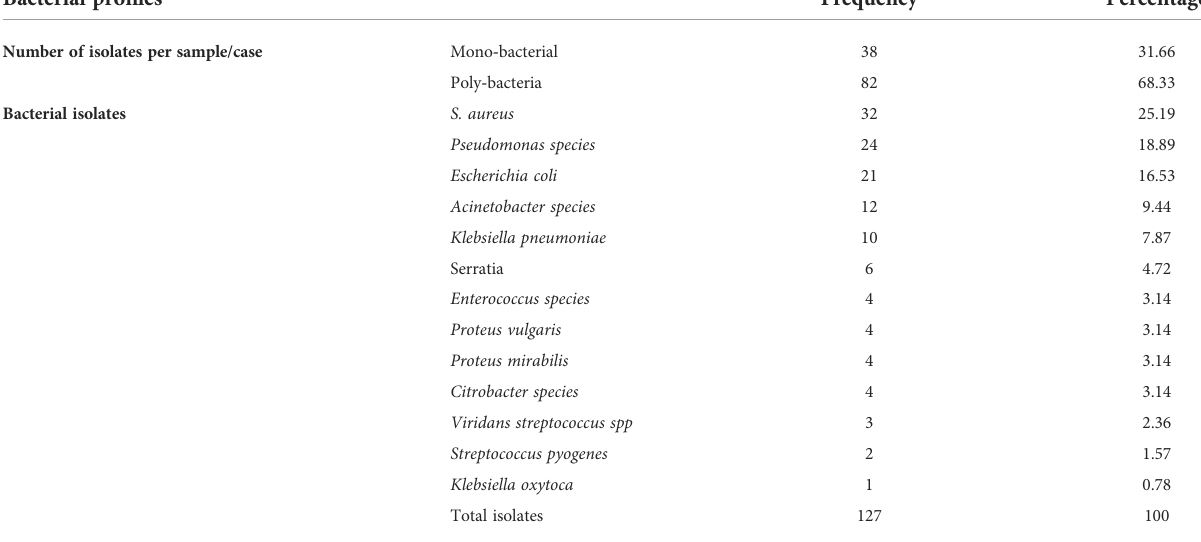
TABLE 2 Bacterial isolates among diabetic foot ulcer study